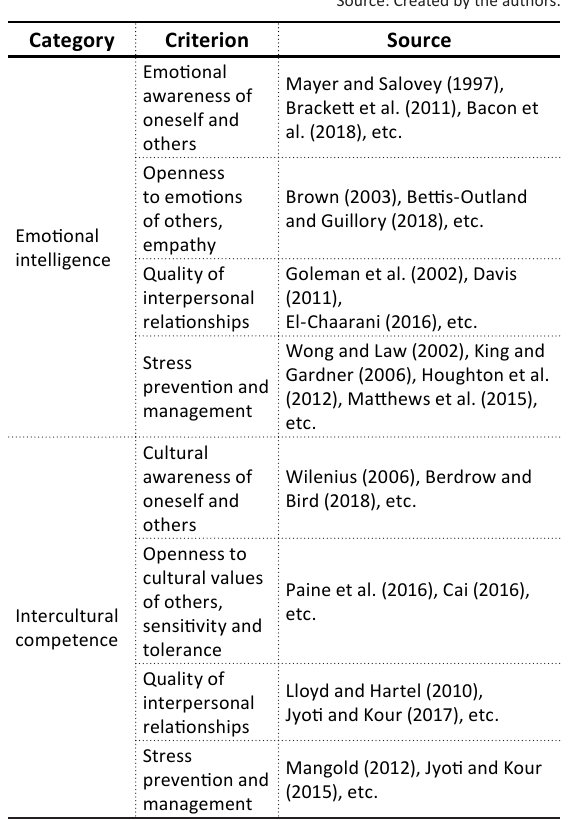
Table 1. Connections between emotional intelligence and intercultural